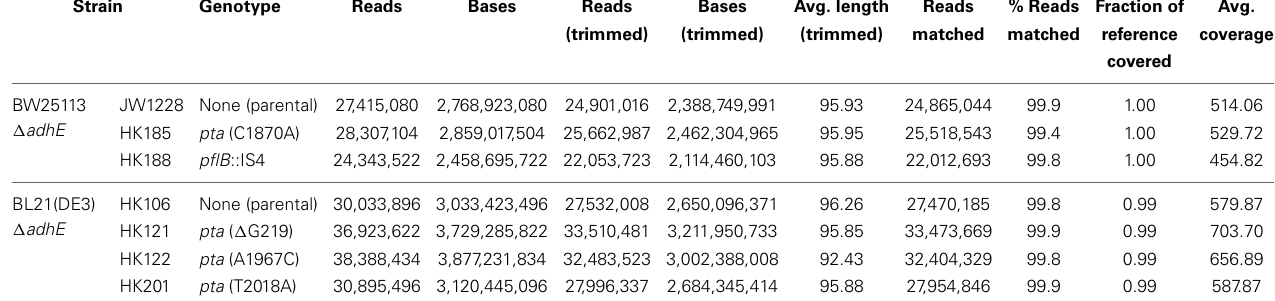
Table 4 | Genomic analysis of E. coli (cid:2) adhE parental and adapted progeny strains. Strain Genotype Reads Bases Reads Bases Avg. length Reads % Reads Fraction of Avg. (trimmed) (trimmed) (trimmed) matched matched reference coverage covered